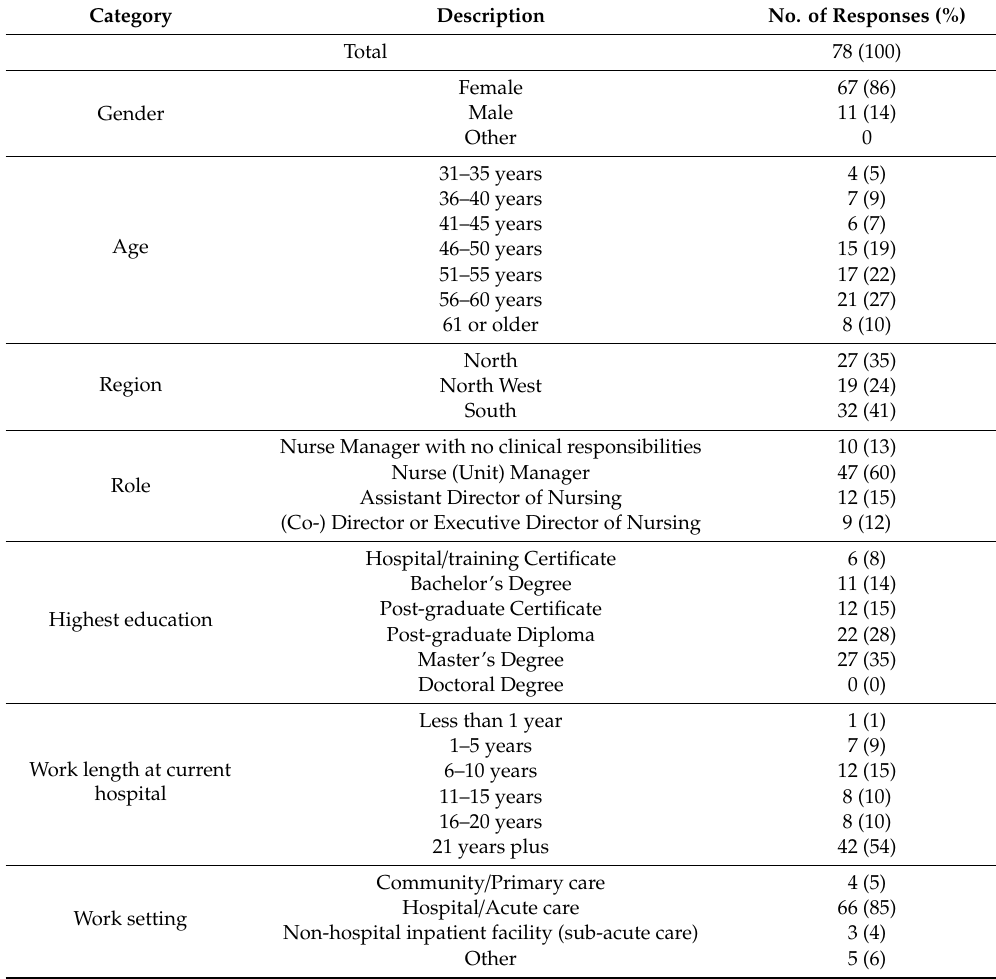
Table 2. Demographic responses of survey